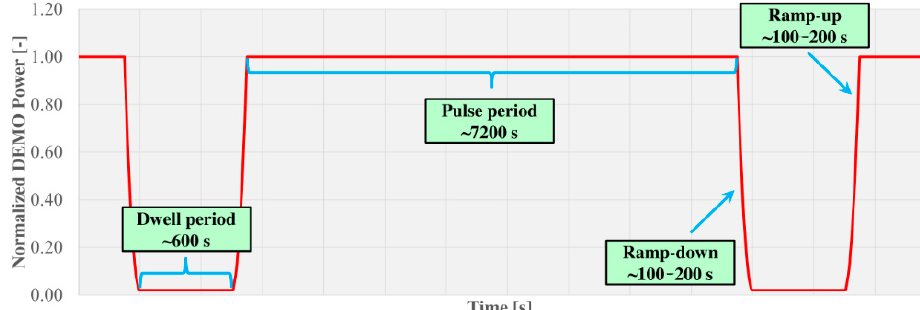
Figure 1. DEMO Primary Heat Transfer System power cycle. Reprinted from [6].